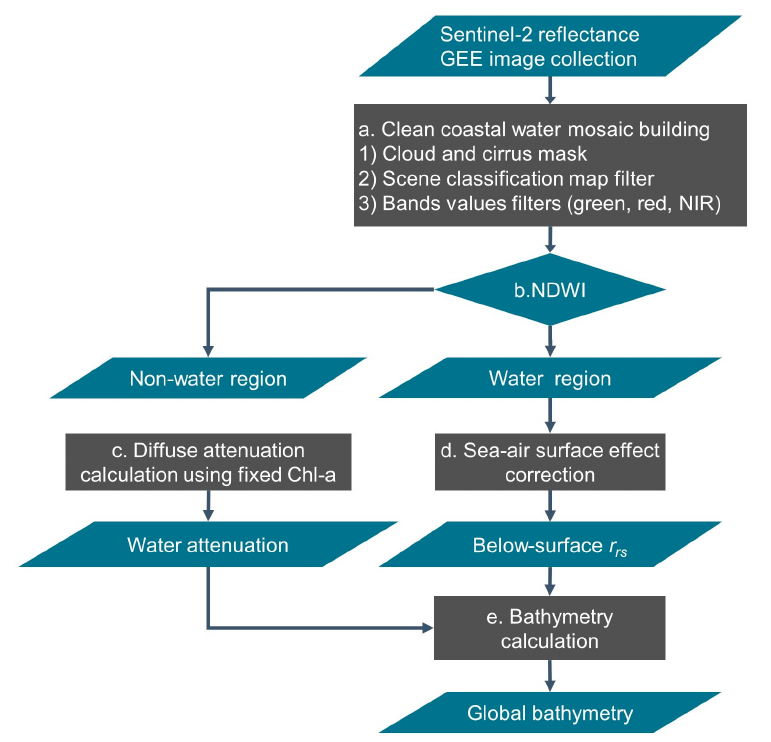
Figure 2. Google Earth Engine global bathymetry estimation diagram. Sentinel-2 satellite reflectance images were selected to build the clean water mosaic to derive bathymetry.